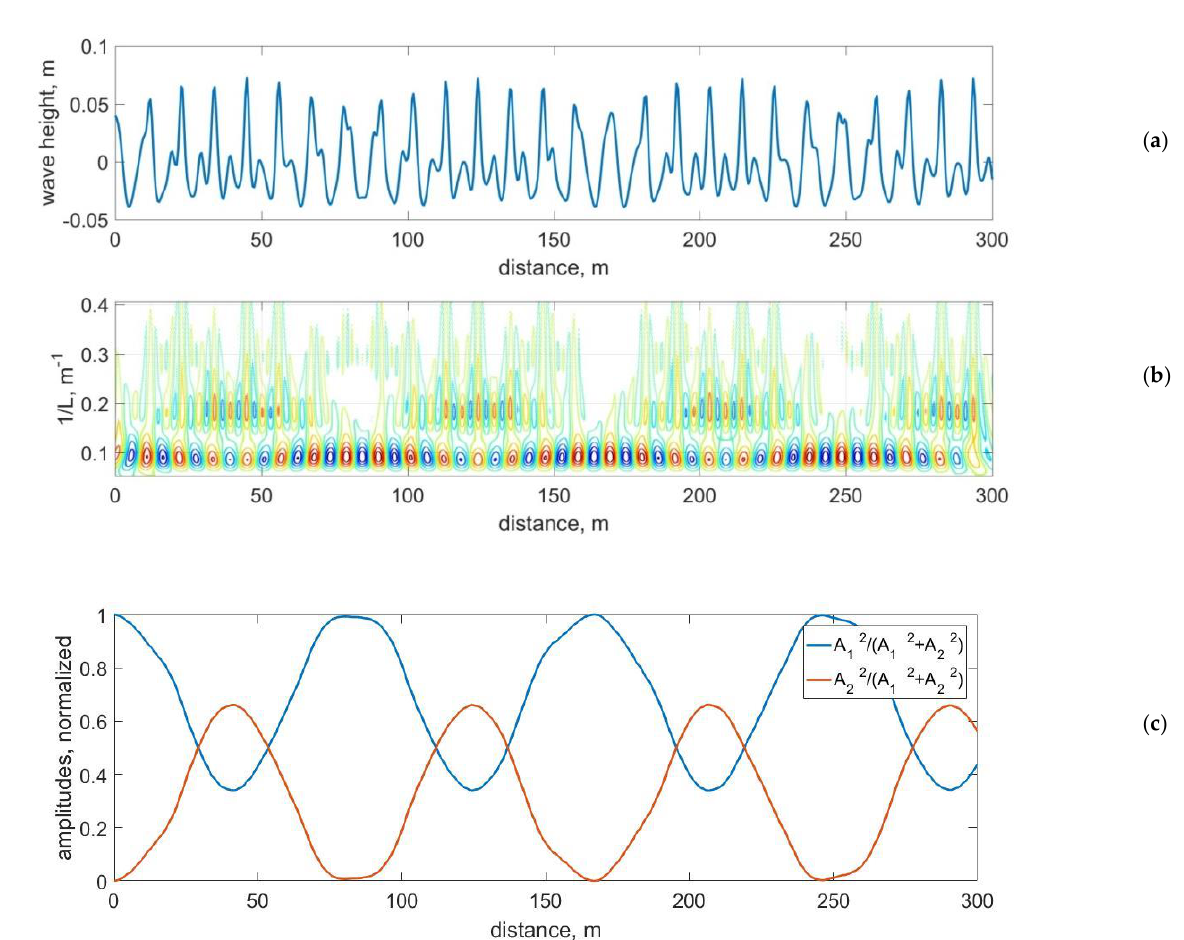
Figure 6. Spatial fluctuations of amplitudes of first and second harmonics of model monochromatic waves propagated over a constant depth of 0.5 m. ( a ) waves evolution with distance, ( b ) its wavelet transform, ( c ) fluctuations of frequency amplitudes corresponding Figure 5a.